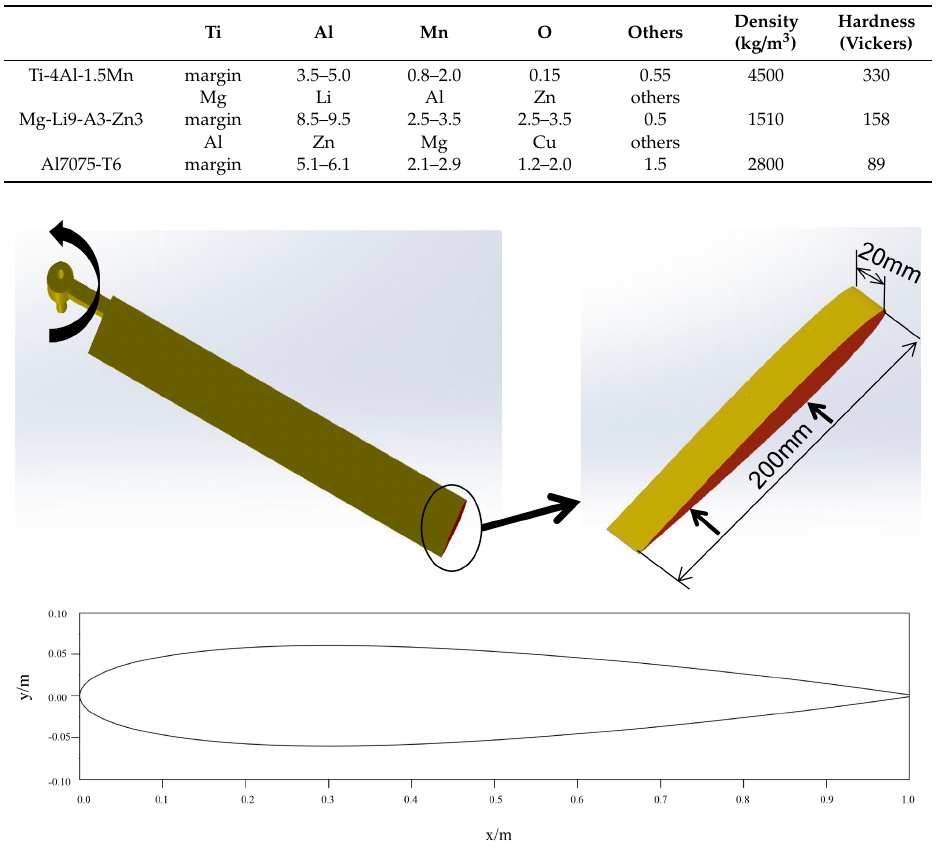
Figure 1. Geometric details of the helicopter rotor blade.